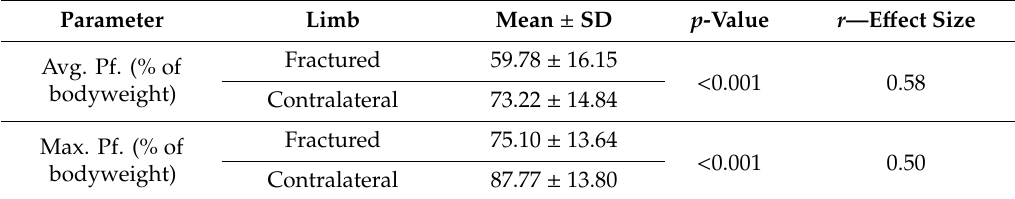
Table 3. Comparison fractured vs. contralateral limb: gait analysis.